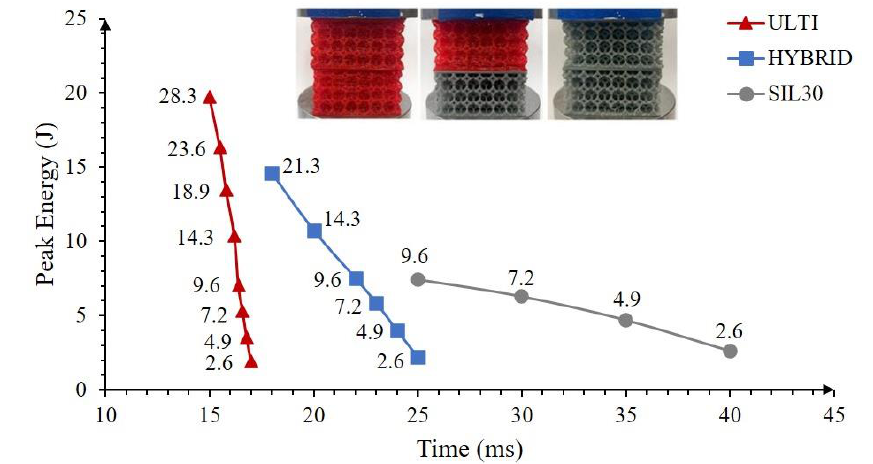
Figure 10. Figure 10. Peak energy absorption from double stacking vertically-graded systems at different im- pact energies.